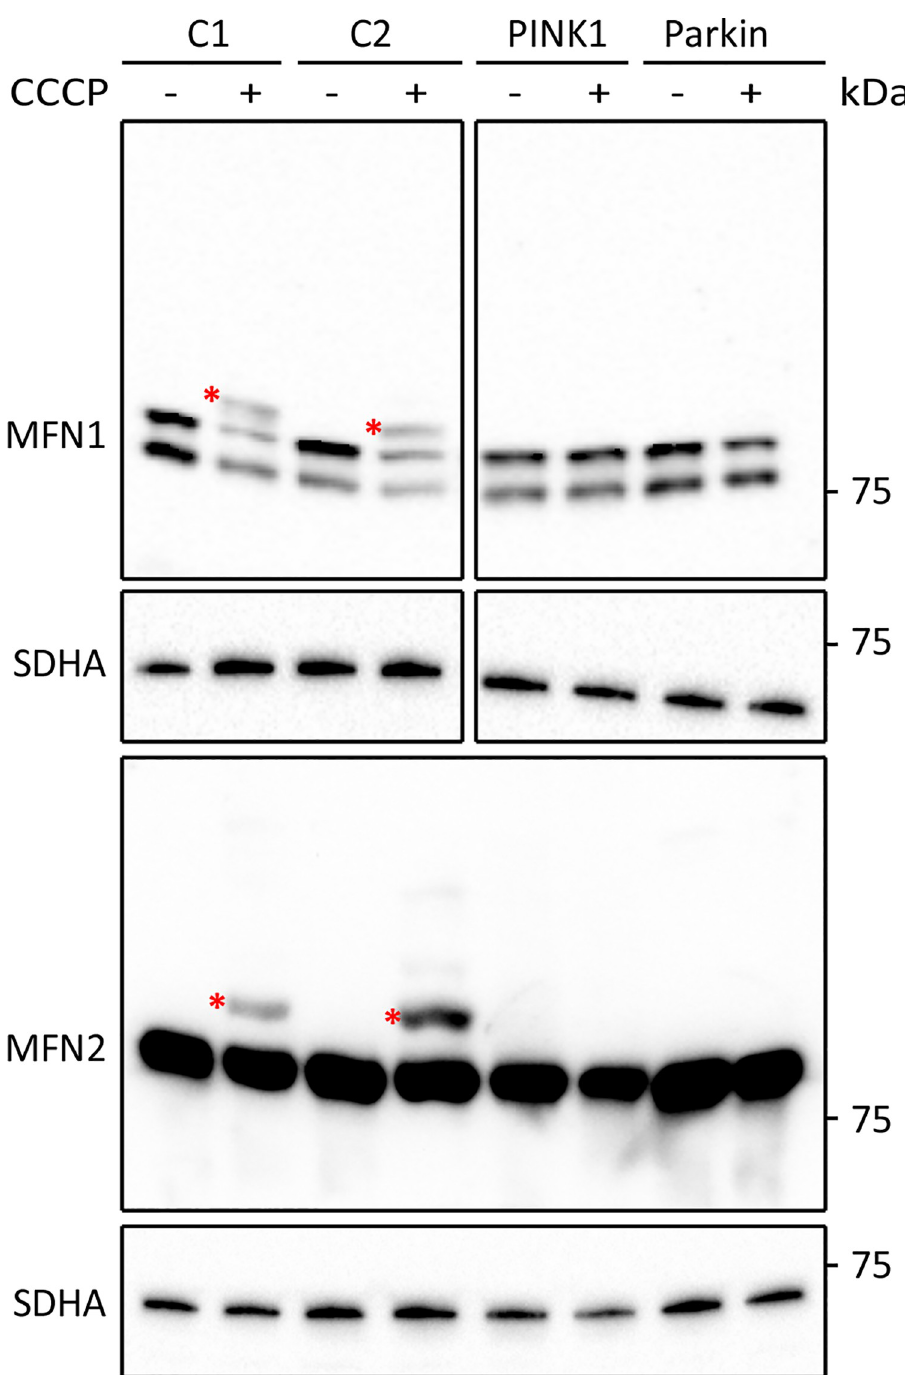
Fig 1. Analysis of CCCP-induced MFN ubiquitination in cultured fibroblast cells. Western blot analysis of fibroblasts from healthy controls (C1 and C2) and two early-onset PD patients with mutations in PINK1 or PRKN . Cells were left untreated or were treated for 2 hours with 20 μ M CCCP. Blots were developed with antibodies against MFN1 and MFN2. Antibodies against SDHA were used as loading control. Asterisks indicate bands representing ubiquitinated MFN